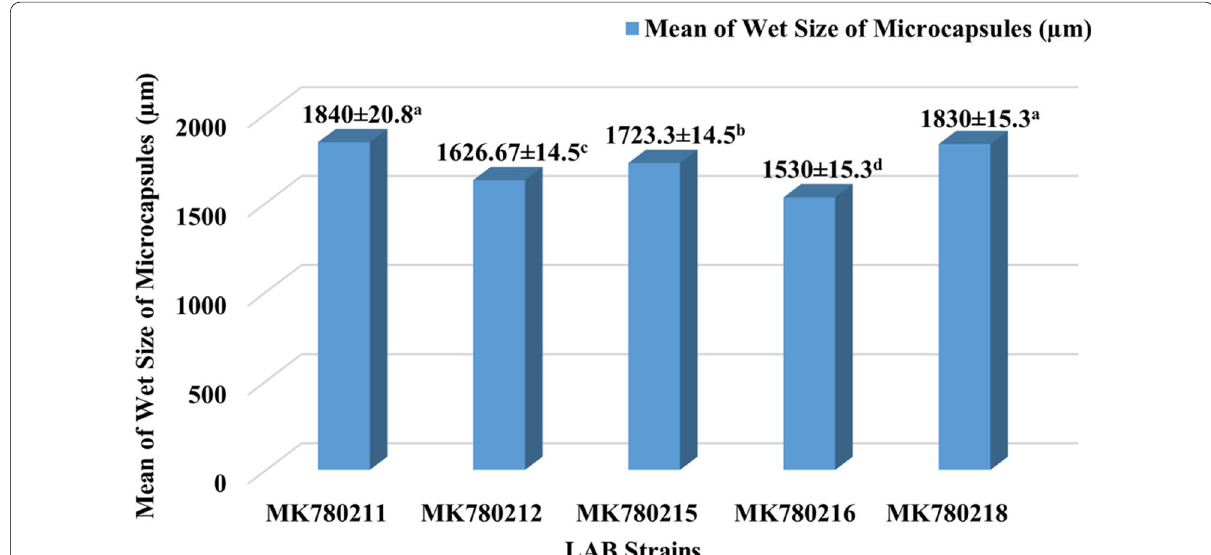
Fig. 3 Mean wet size ( STD) of the double-coated microcapsules. Uppercase letters are results of Tukey test. a − d Means with the same letter are ± not significantly different at sig. ( p 0.05) ≤